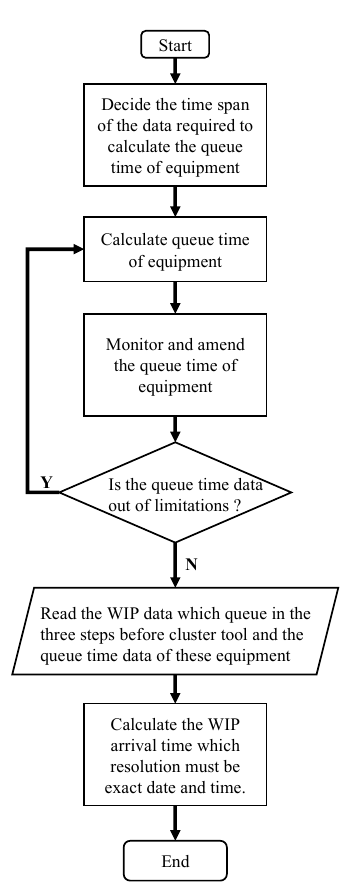
Figure 2. Flowchart of WIP arrival time estimation.